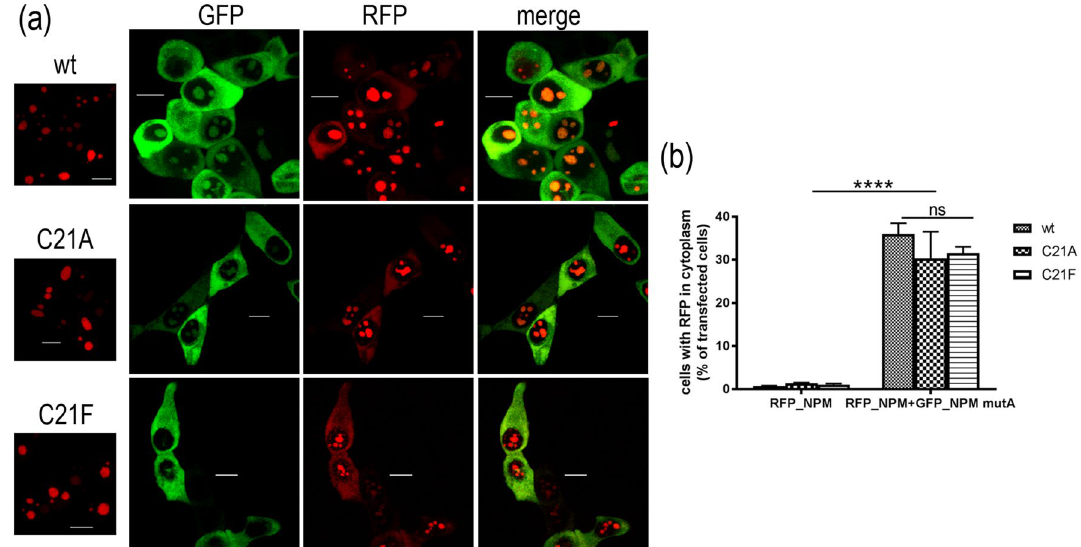
Figure 1. Interaction between NPMmut and C21 point mutants. ( a ) Left: localization of R_NPMwt/ C21A/C21F in single transfected 293T cells. Right: 293T cells co-transfected with G_NPMmut (green) and R_NPMwt/C21A/C21F variants (red). Red signal in the cytoplasm and green signal in nucleoli witness for an interaction between NPMmut and NPMwt/C21A/C21F. ( b ) Statistical evaluation of the subcellular localization of NPMwt and C21 mutants. Fraction of transfected 293T cells displaying red signal from the cytoplasm in single transfected cells (left group) and in cells co-transfected with G_NPMmut (right group). Error bars represent ± SD of at least 3 independent experiments, p < 0.0001 (****) for the differences between the co-transfected and the single-transfected